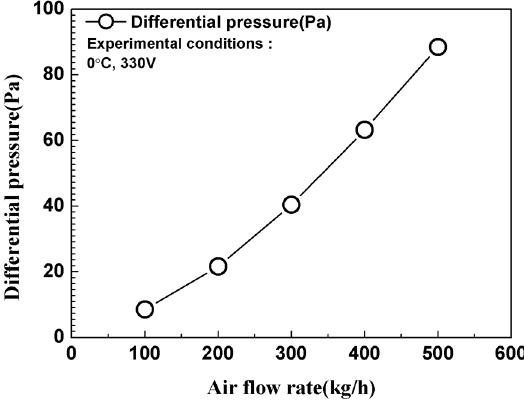
Figure 4. Variation of differential pressure.